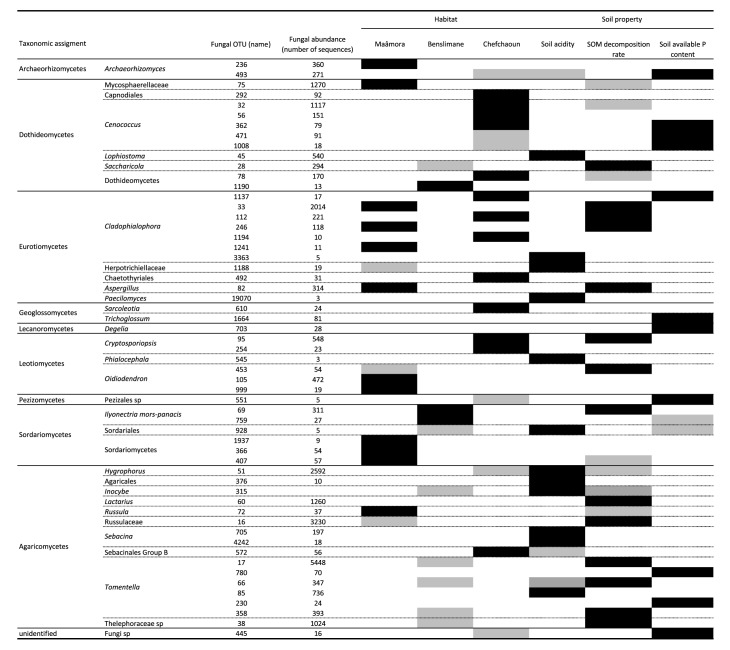
Major fungal indicators of habitat and soil property.Only fungal indicators with a significant association with at least one ecological condition (black box) are shown, i.e. fungal OTUs associated with a habitat with r.g > 0.5 and P < 0.01 and/or a soil property with A > 0.8, B > 0.6 and P < 0.01. For certain major fungal indicators, a low but significant association with a habitat (r.g > 0.5 and 0.01 < P < 0.05) and/or a soil property (A > 0.8, B > 0.6 and 0.01 < P < 0.05) was also revealed (gray box). See S3 and S6 Tables for details. The taxonomic assignment is provided until genus level, except for those with an unidentified genus (where higher taxonomic level is indicated).